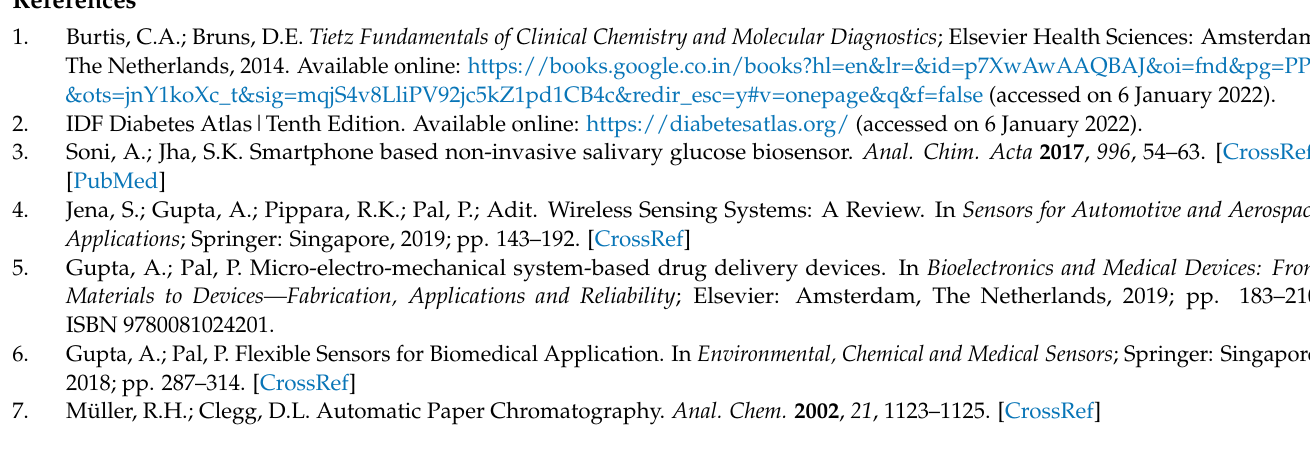
Figure S8: The variation of overall skewness of all the training images (a) HSV (b) L*a*b (c) xyz (d) NTSC (e) RGB; Figure S9: The variation of overall kurtosis of all the training images (a) RGB (b) HSV (c) L*a*b (d) xyz (e) NTSC; Figure S10: The variation of overall values of training images obtained from GLCM (a) correlation, (b) energy, (c) contrast, (d) intensity, (e) homogeneity, and (f) entropy; Figure S11: Colour image of unknown samples for the testing of trained data; Figure S12: Shelf-life testing of spots kept at room temperature and at 4 ◦ C for 14